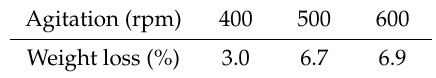
Table 1. Influence of wastewater agitation on the stability of PVC/DBP/poly( β -cyclodextrin) membrane. Agitation (rpm)